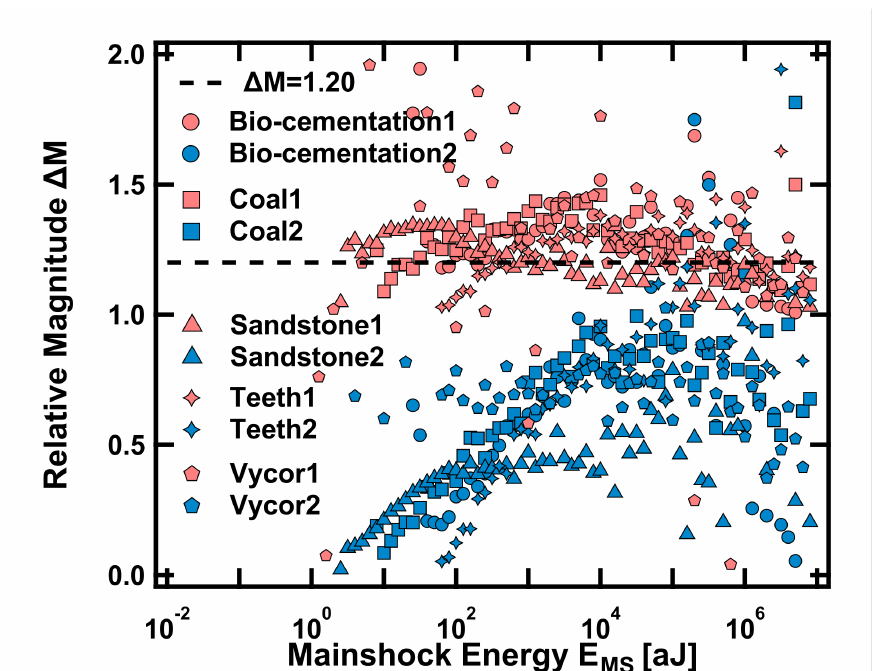
Figure 14. The relationship between relative magnitude and mainshock energy for all samples, blued results are calculated by ∆ M = log 10 (E MS /E AS* ), and red results are from ∆ M = log 10 (E MS )/log 10 (E AS*